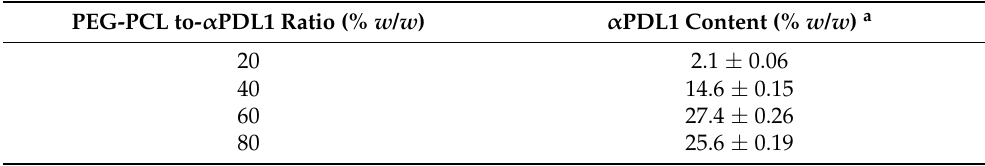
Table 1. α PDL1 contents of α PDL1-PEG-PCL nanoparticles with various PEG-PCL amounts used in the nanoprecipitation process.